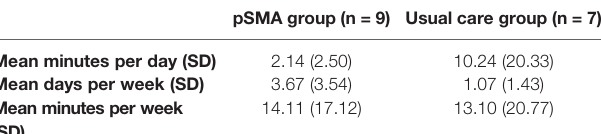
TABLE 9 | Time spent meditating throughout intervention